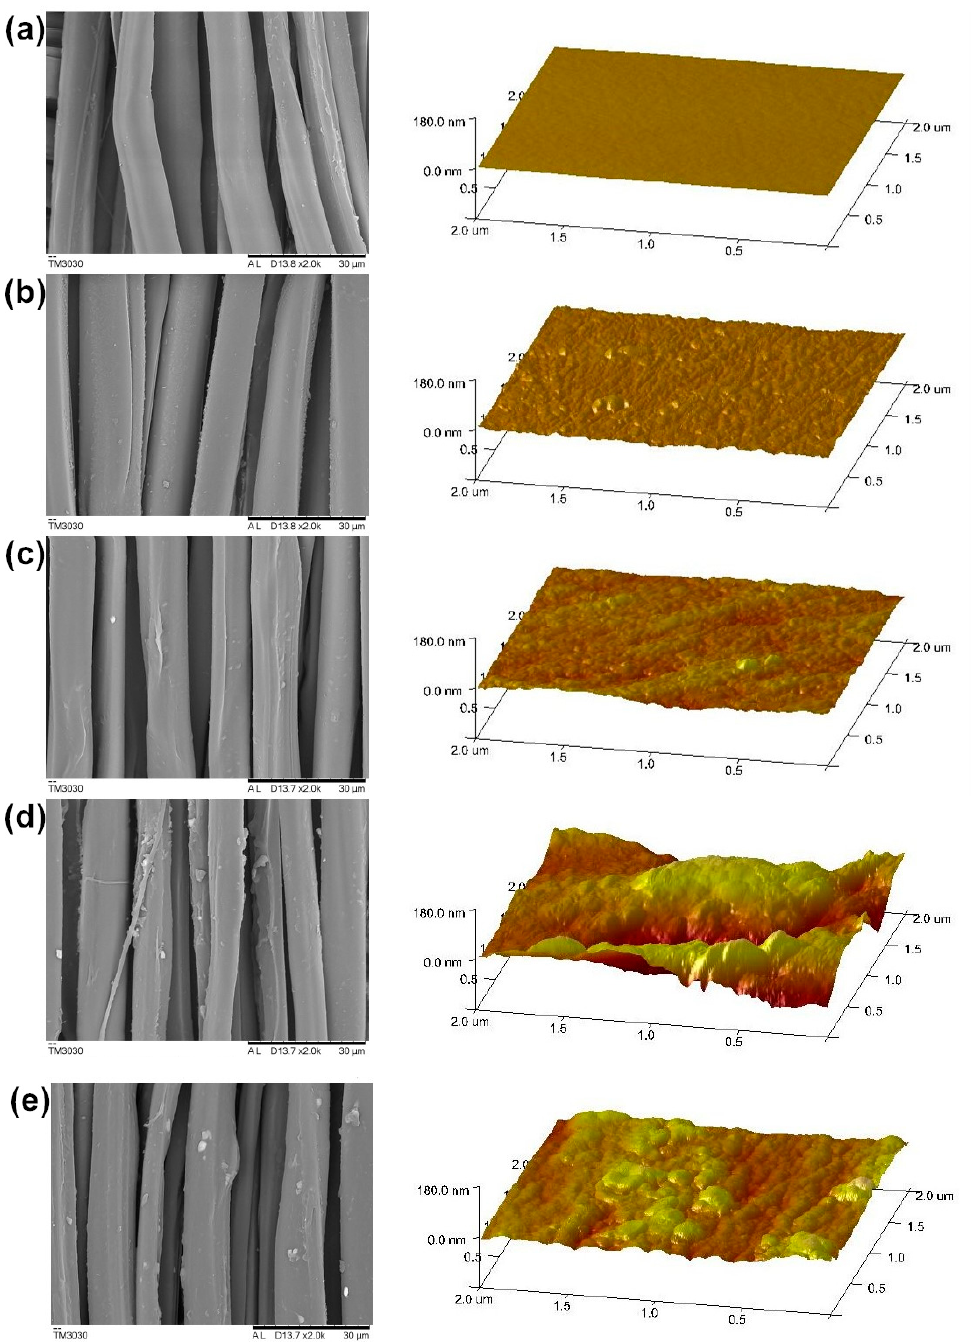
Figure 5. SEM and AFM images about silk samples (( a ) untreated; ( b ) DA; ( c ) DA–Fe 3+ ; ( d ) DA–Ox; ( e ) DA–Fe 3+ –Ox).